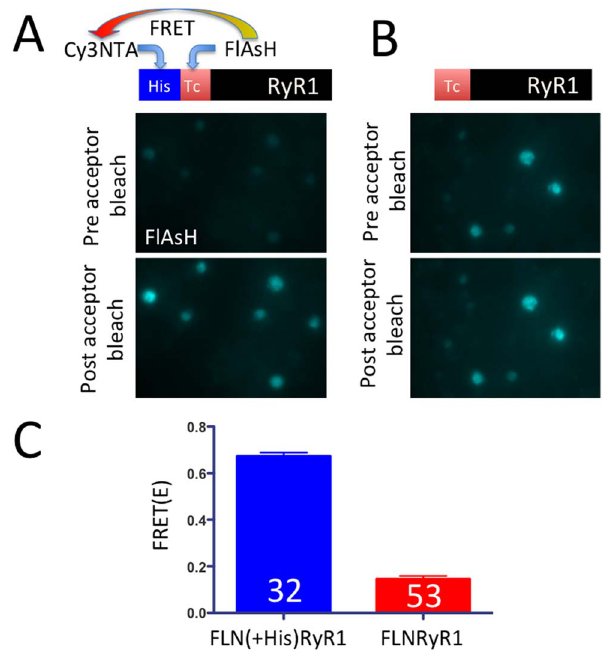
Figure 6. FRET analysis of FlAsH-labeled RyR1 constructs. HEK- 293T cells expressing either FLN( + His)RyR1 (A) or FLNRyR1 (B) were labeled with FlAsH (acting as FRET donor) and Cy3NTA (FRET acceptor). FlAsH fluorescence was recorded before (top panels) and after (bottom panels) photobleaching of the Cy3NTA acceptor. FRET was observed as an increase in FlAsH fluorescence after acceptor photobleaching. (C) Mean FRET efficiencies are shown for FlAsH-labeled FLN( + His)RyR1 and FLNRyR1 using Cy3NTA as FRET acceptor. Values represent mean + / 2 S.E.M for the number of cells indicated in each bar.